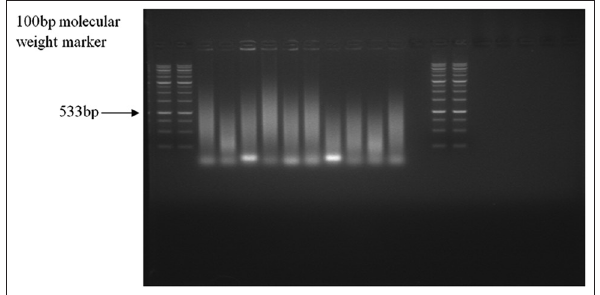
Figure-3: Agarose gel electrophoresis pattern of polymerase chain reaction of methicillin-resistance Staphylococcus aureus isolate. Lane M: Molecular weight marker. Lane 1-10: Negative for mecA . Lane C: Negative